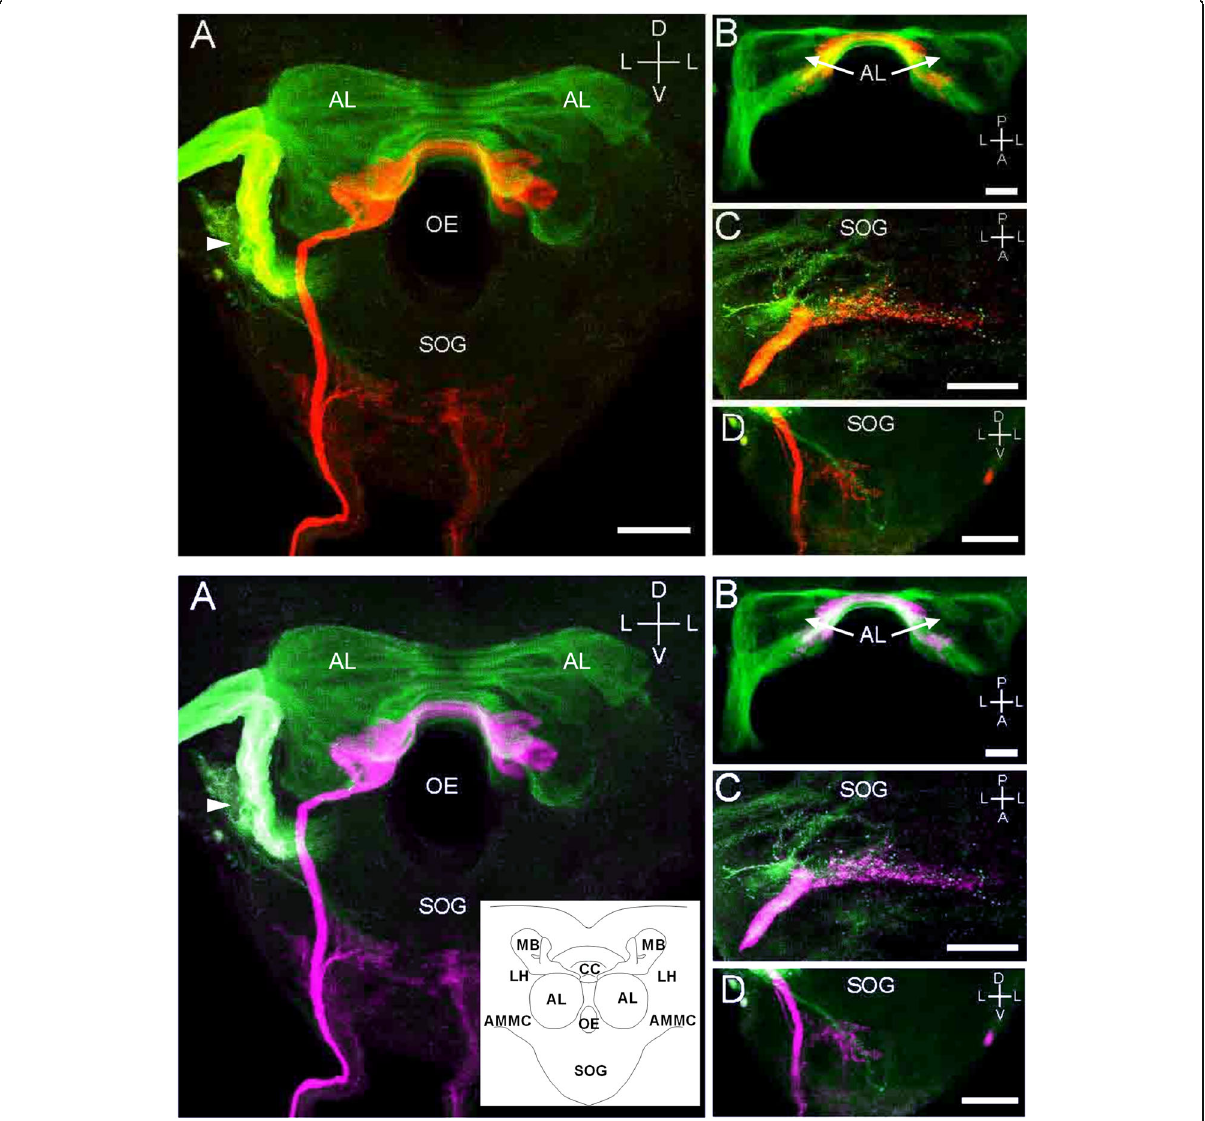
Fig. 1 Top: Double labeling of ORNs from the right antenna (green) and the right maxillary palp (red) in the brain. Bottom: Same as Top, but red and green are converted to magenta and cyan, respectively. a – d are image stacks of 61, 23, 27, and 70 confocal sections at 2.2-, 1.5-, 0.75-, and 0.75- μ m intervals, respectively. a Frontal view of AL, b horizontal view of AL, c horizontal view of SOG, and d frontal view of SOG. The arrowhead in ( a ) indicates the AMMC region. Bars indicate 50 μ m. The inset is a schematic drawing of the neuropil organization of the blowfly brain. CC, central complex; LH, lateral horn; MB, mushroom body; OE,